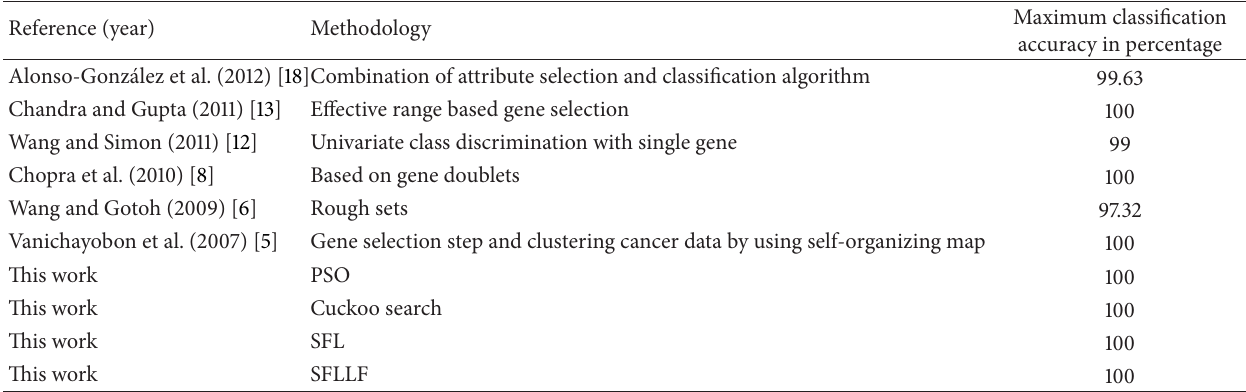
Table 12: Comparison of classification accuracy with other methods for Lung